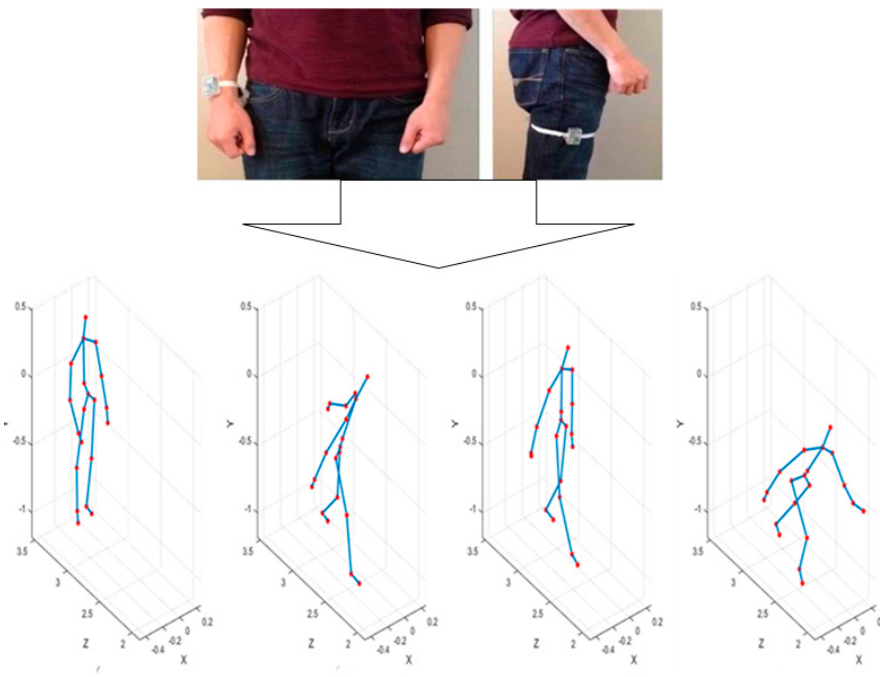
Figure 6. Example of bowling action of UTD-MHAD.